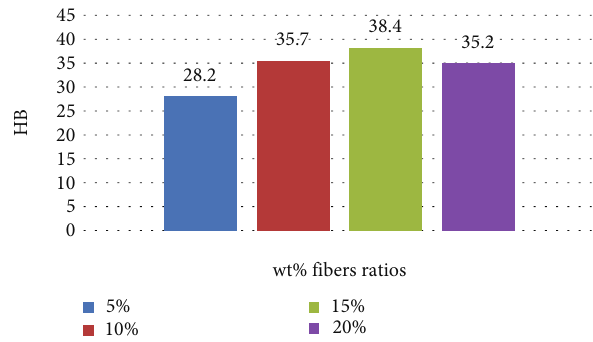
Figure 5: Average hardness values for Epoxy – DPF composites for di ff erent DPF weight